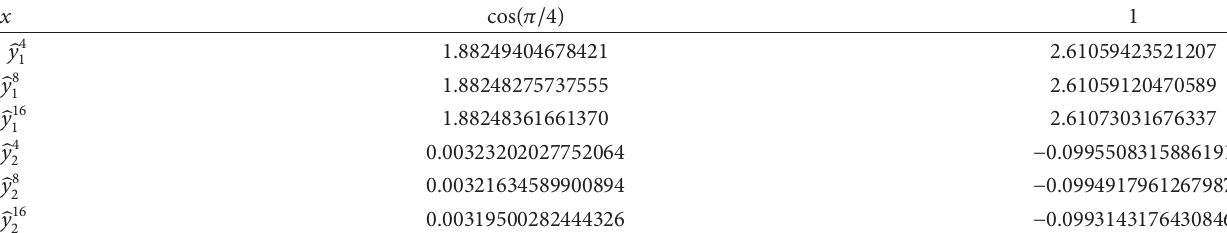
Table 2: Approximations for 𝑦(𝑥) + ∫